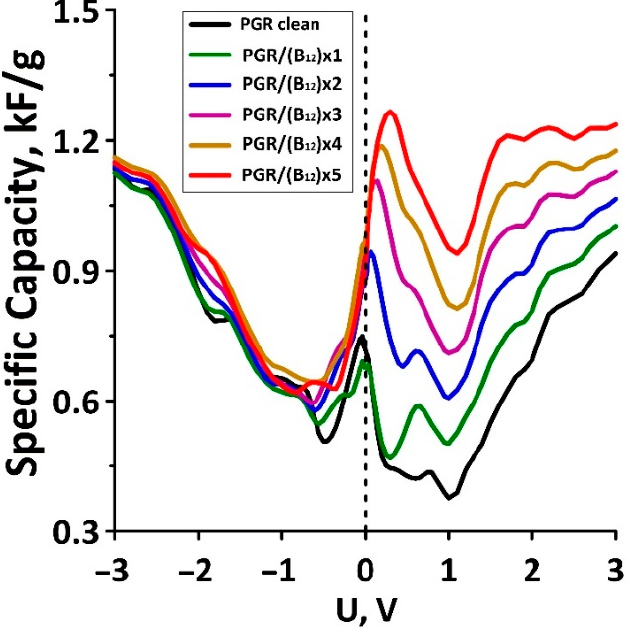
Figure 3. C Q for the pure PGR and for PGR decorated with 1 to 5 boron clusters. Table 1. Heat of formation, specific charge density, and specific capacitance for the pure PGR and for the PGR decorated with 1 to 5 boron